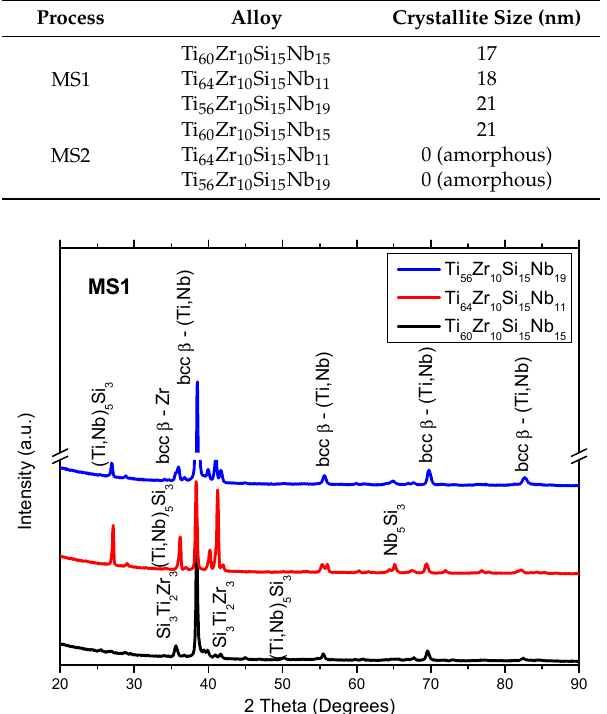
Figure 1 . X-Ray Diffraction patterns of Ti–Zr–Si–Nb bulk alloys. Table 2. Crystallite size for the melt-spun ribbons, estimated with the Scherrer equation. Process Alloy